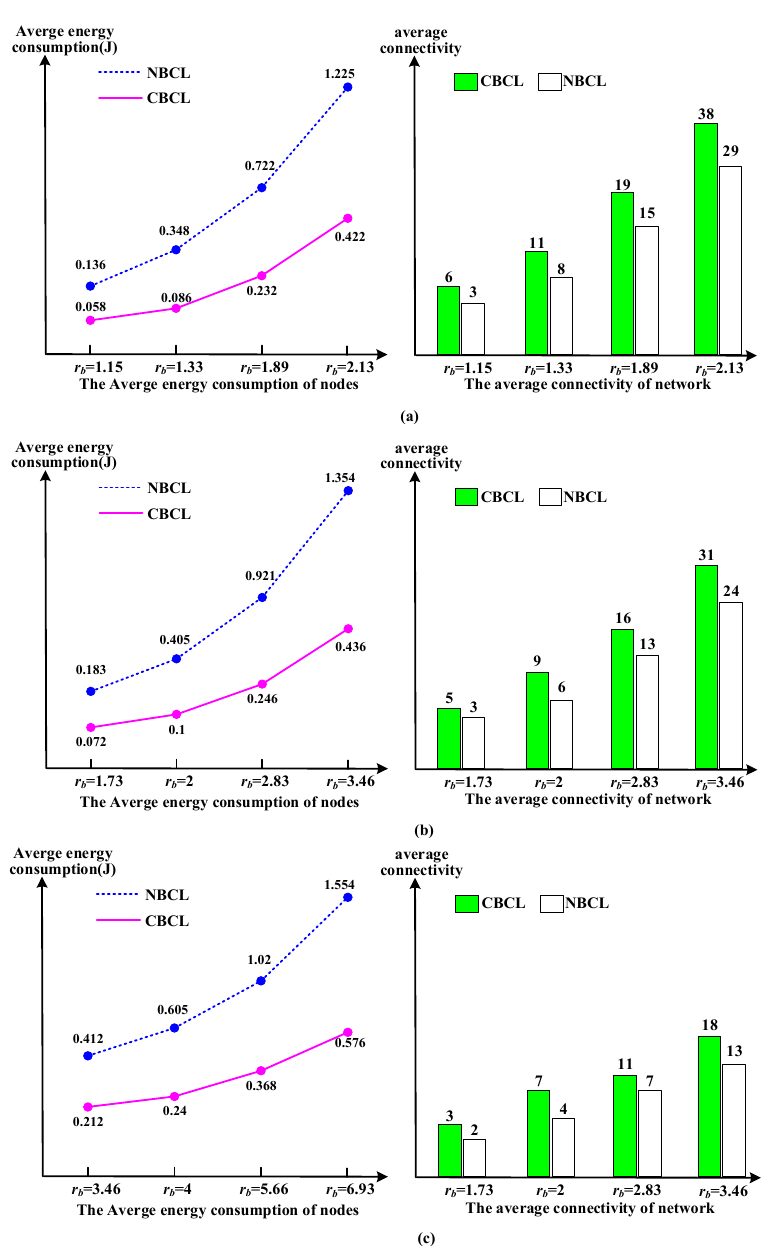
Figure 9. The energy consumption and connectivity: ( a ) d b = 0.67; ( b ) d b = 1; ( c ) d b = 2.